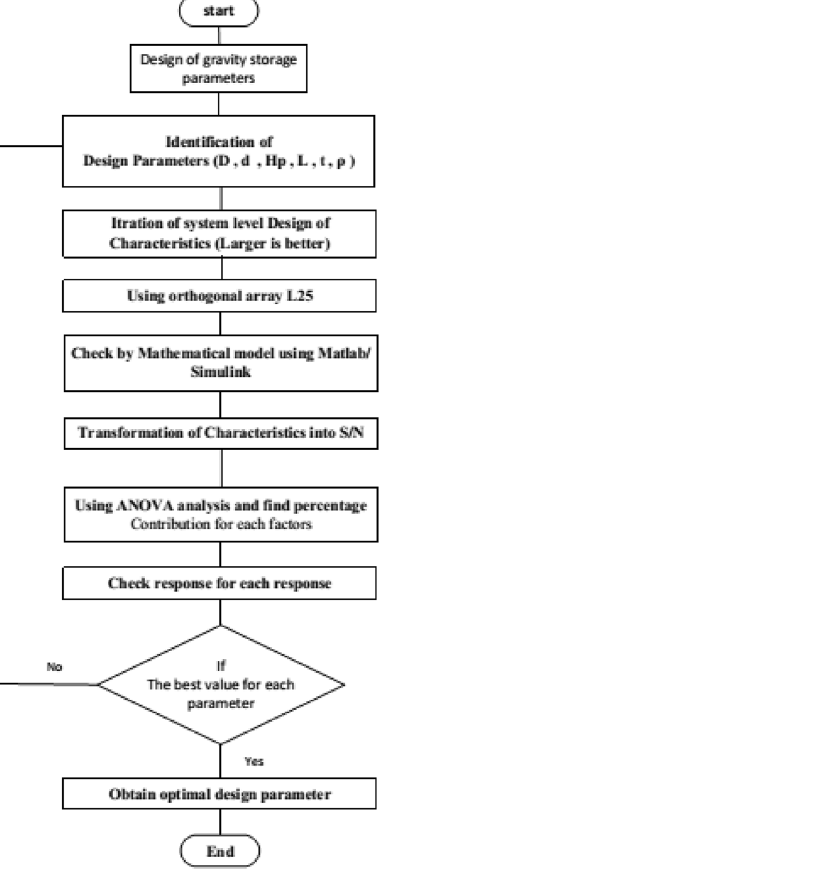
Figure 2. Flow chart for the presented